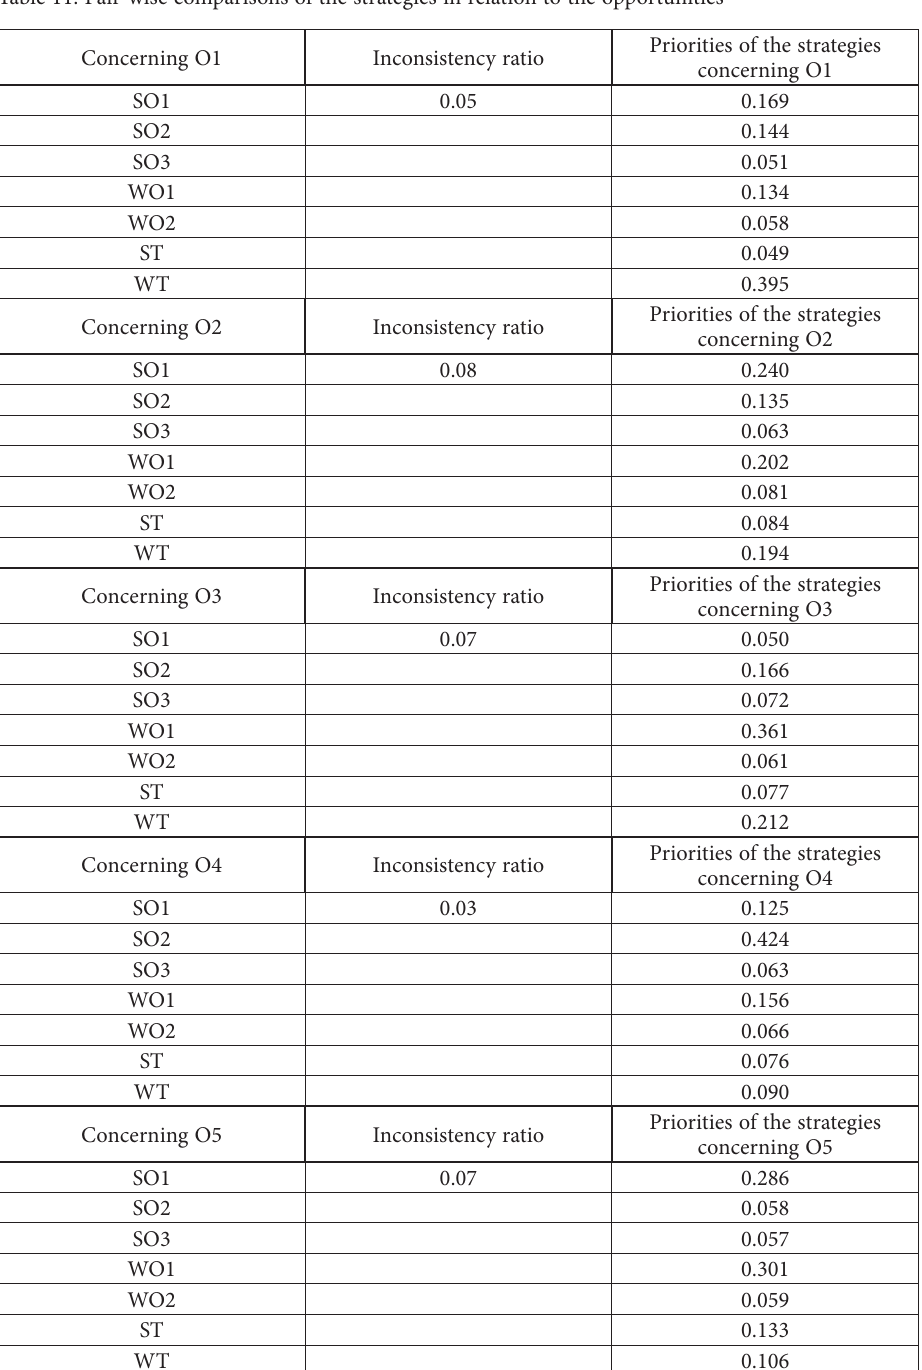
Table 11. Pair-wise comparisons of the strategies in relation to the opportunities Concerning